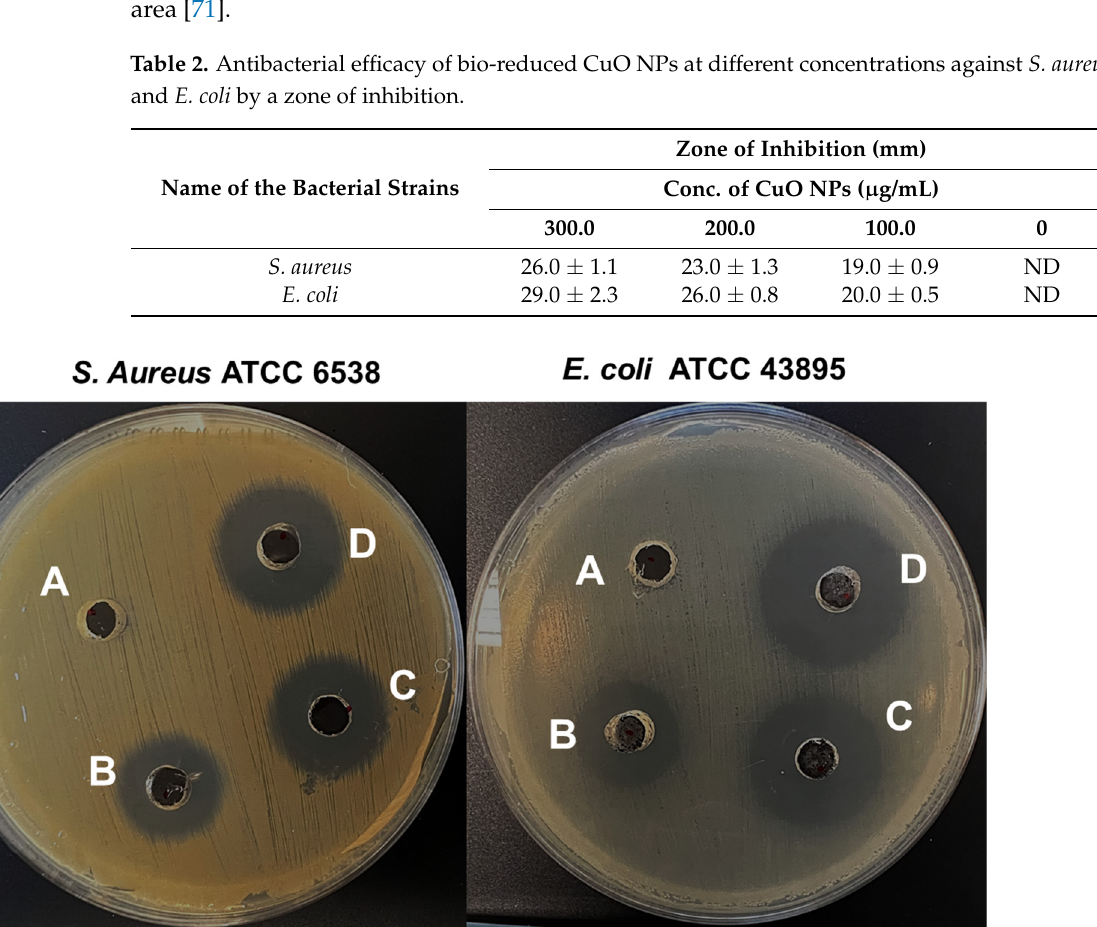
Figure 10. Antibacterial efficacy of bio-reduced CuO NPs with different concentrations ( A , 0 µg/mL; B , 100 µg/mL; C , 200 µg/mL; and D , 300 µg/mL). Table 2. Antibacterial efficacy of bio-reduced CuO NPs at different concentrations against S. aureus and E. coli by a zone of